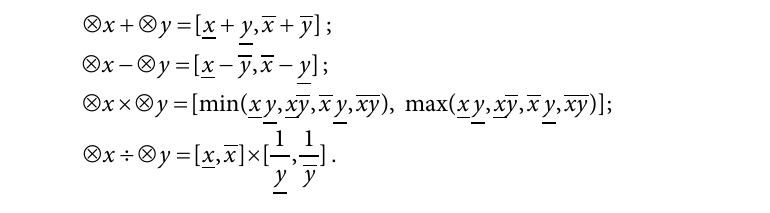
be two grey numbers. Mathematical